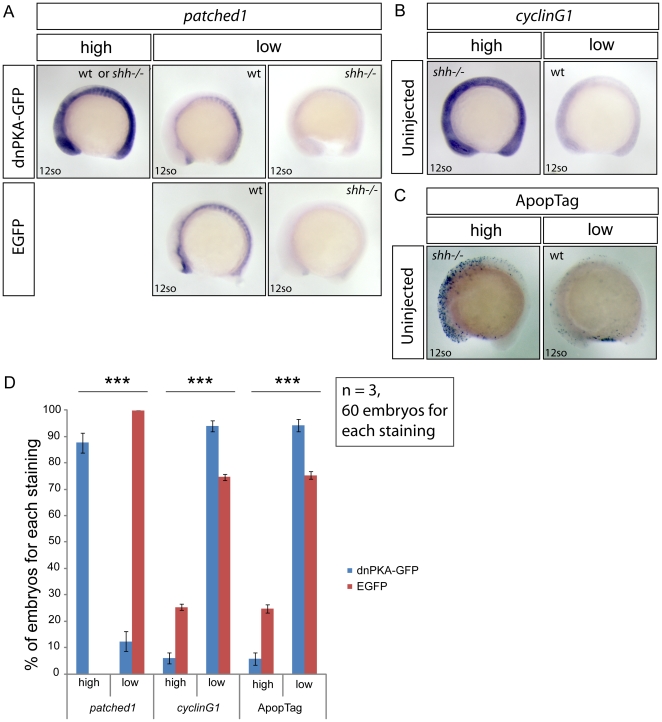
Hh signaling activation by dnPKA-GFP decreases p53 target cyclinG1 expression and suppresses apoptosis in shh
−/− mutant embryos.Embryos from shh
+/– parent fish were injected with either dnPKA-GFP or EGFP mRNA, grown to 12-somite stage and in situ stained for patched1, target gene of Hh signaling, and cyclinG1, p53 target gene, and ApopTag staining was performed to characterize the level of apoptosis. (A) Injection of dnPKA-GFP led to a strongly increased and more widely spread expression of patched1 (category “high”) in 87,7+/−3,8% of injected embryos, the rest having normal wild-type or low shh
−/− mutant patched1 expression comparable to expression of patched1 in EGFP-injected embryos from shh
+/– parent fish (category “low”). (B) Expression of cyclinG1 in uninjected embryos from shh
+/– parent fish. Categories “high” and “low” indicate expression levels in shh
−/− mutant and wild-type embryos, respectively. (C) ApopTag staining of apoptotic cells in uninjected embryos from shh
+/– parent fish. Categories “high” and “low” indicate levels of apoptosis in shh
−/− mutant and wild-type embryos, respectively. (D) Statistical analysis of results from injections of dnPKA-GFP and EGFP mRNA into embryos from shh
+/– parent fish. All of EGFP-injected embryos had “low” expression of patched1, 25,3 +/− 1,15% (Mean +/− standard deviation) of them had “high” expression of cyclinG1 and 24,7 +/− 1,53% had “high” apoptosis levels. dnPKA-GFP mRNA injection led to “high” expression of patched1 in 87,7 +/− 3,8% of embryos and decreased expression of cyclinG1 and apoptosis levels: “high” proportions are 6 +/− 2% and 5,8 +/− 2,4%, respectively. The experiment was done 3 times and 60 embryos were used for each staining. Asterisks (***) on top of shh
−/− mutant bars indicate significant statistical differences of proportions (Fisher's exact test, P-value<0,001).